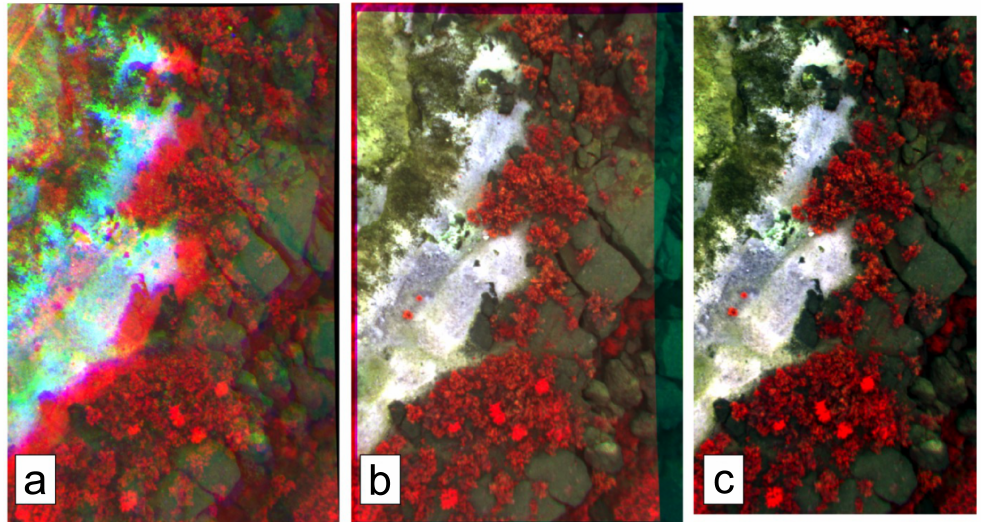
Figure 4. Rikola image before ( a ) and after ( b ) band co-registration and after subsequent residual edge cutting ( c ). Displayed bands are: red: Band 42 (832nm); green: Band 23 (680 nm); blue: Band 1